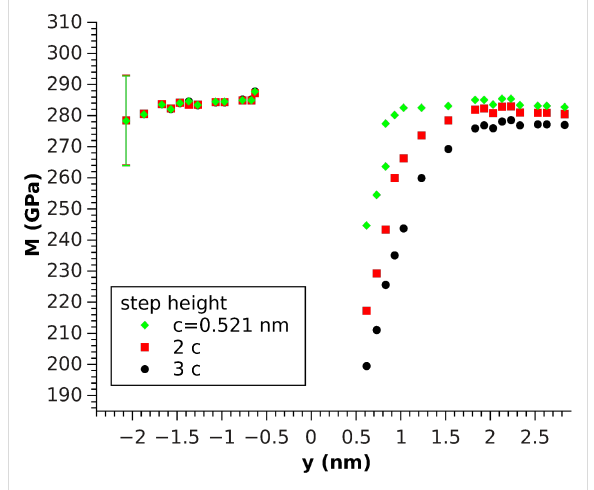
Figure 4: [001]-oriented indentation modulus for three different step heights along y . Measured by indenting a circular region of surface atoms ( A 2 = 1.232 nm 2 ). The error bars denote the standard deviation of the displacement and apply to all data